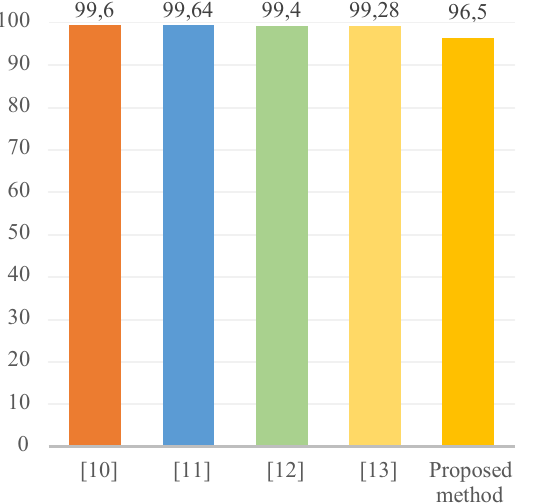
Fig. 5. ROC curves (a) using CNN, (b) using histogram equalization combined with CNN, (c) using a MobileNet